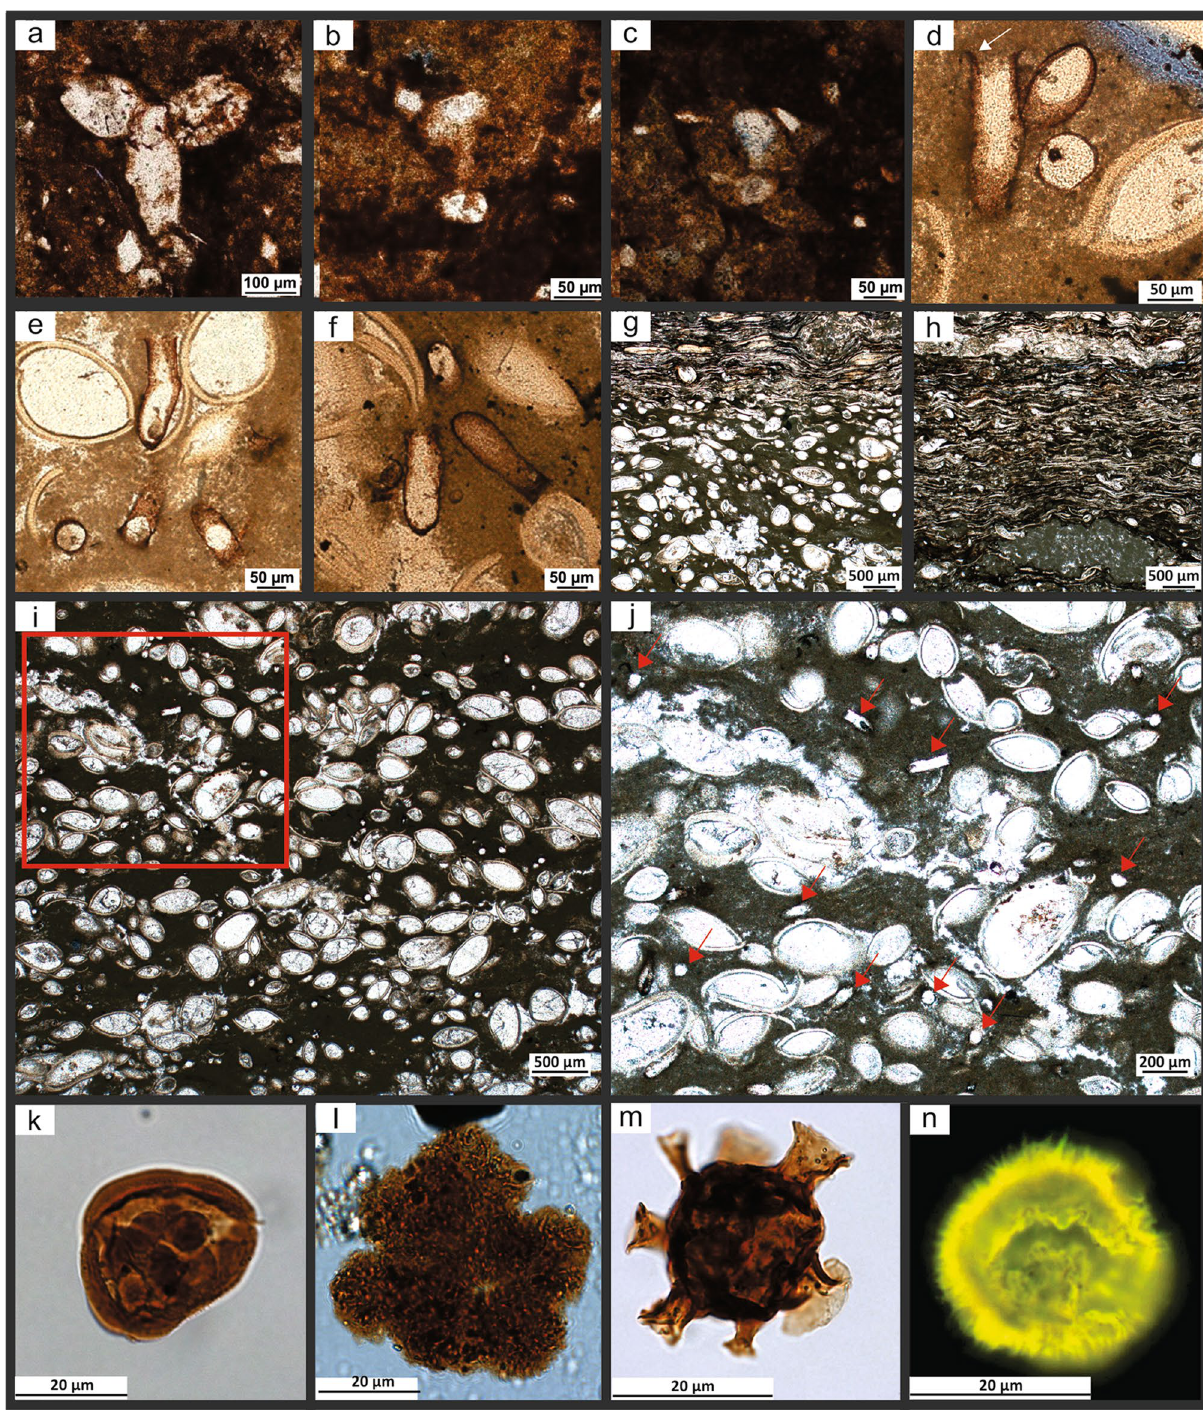
Figure 5. Key microfossil species recovered (1PS-06-CE and 1PS-10-CE boreholes): ( a ) Leupoldina sp. (1PS-06-CE, 39.20 m); ( b ) Globigerinelloides cf. barri (1PS-06-CE, 39.20 m); ( c ) Globigerinelloides cf. ferreolensis (1PS-06-CE, 39.20 m); ( d ) Serpulids (collar = white arrows) (1PS-10-CE, 100.45 m); ( e,f ) Serpulids (1PS-06-CE, 99.30 m); ( g,h ) Wackestone and packstone with ostracods (1PS-06-CE, 99.30 m); ( i ) Wackestone with ostracods and serpulids (red frame corresponds to image “( j )”) (1PS-06-CE, 99.30 m); ( j ) Detail view of wackestone with ostracod shells and serpulid tubes (red arrows) (1PS-06-CE, 99.30 m); ( k ) Sergipea variverrucata (1PS-10-CE, 104.2 m); ( l ) Botryococcus sp. (1PS-10-CE, 104.2 m); ( m ) Oligosphaeridium sp. (1PS-06-CE, 115.8 m); and ( n ) Cometodinium sp. (1PS-10-CE, 101.5 m; fluorescence